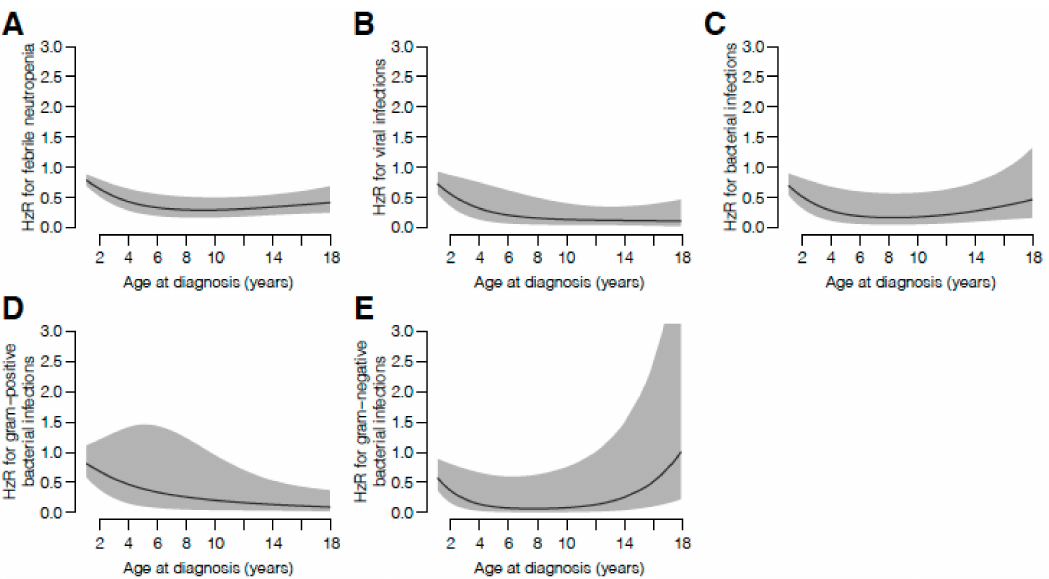
Figure 2. ( A – E ): Age impact on the risk of FN and respective MDI. Hazard ratio (HzR) for a one-year increase in age at diagnosis, calculated using 3-knot restricted cubic splines for age in Andersen–Gill models, for ( A ) febrile neutropenia, ( B ) viral infections, ( C ) bacterial BSI, ( D ) Gram-positive BSI, ( E ) Gram-negative